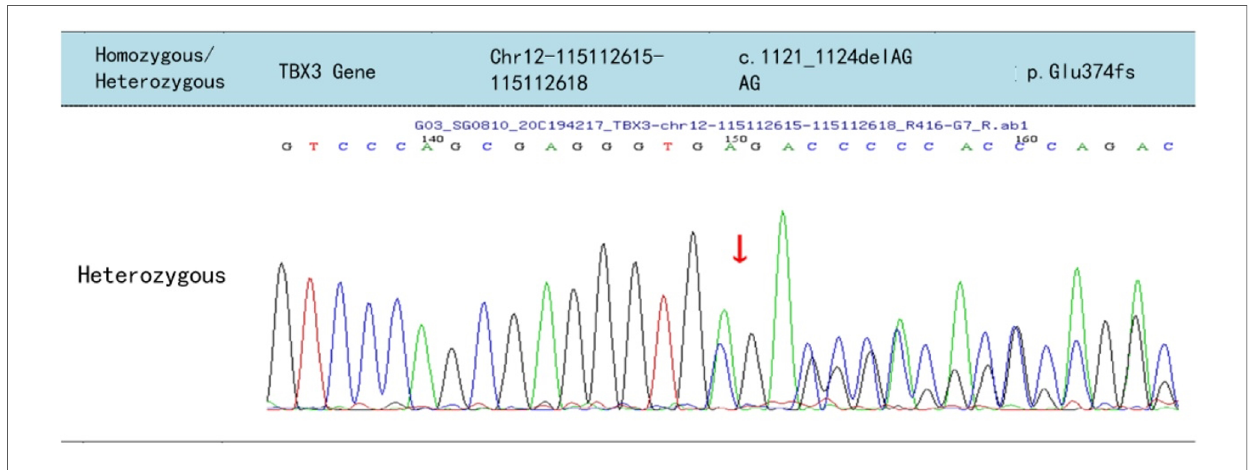
FIGURE 5 Sequencing results of the TBX3 of the patient, the arrows indicate the deletion of AGAG from positions 1,121 to 1,124 in the cDNA, resulting in frameshift mutation of the glutamic acid at position 374 of the TBX3 protein.